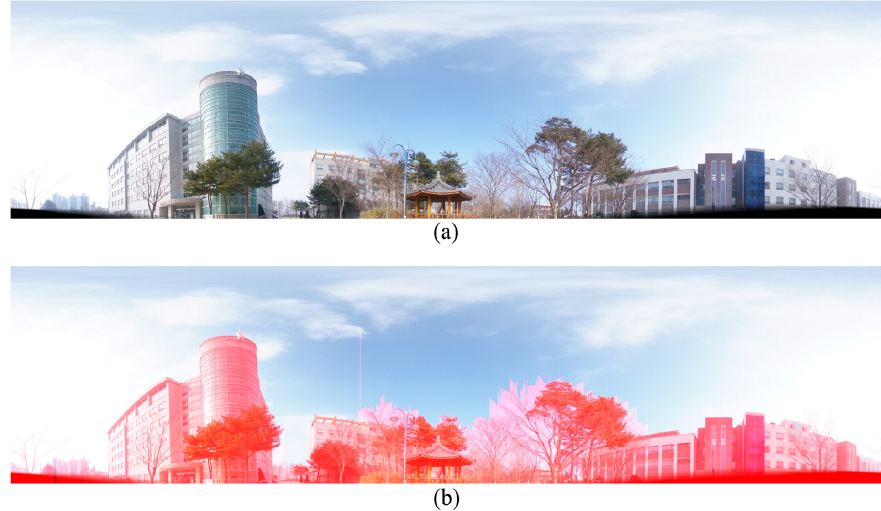
Figure 7. Example of ( a ) panoramic photo, and ( b ) sky classification result of the study area using the fish-eye lens of a 360-degree camera.